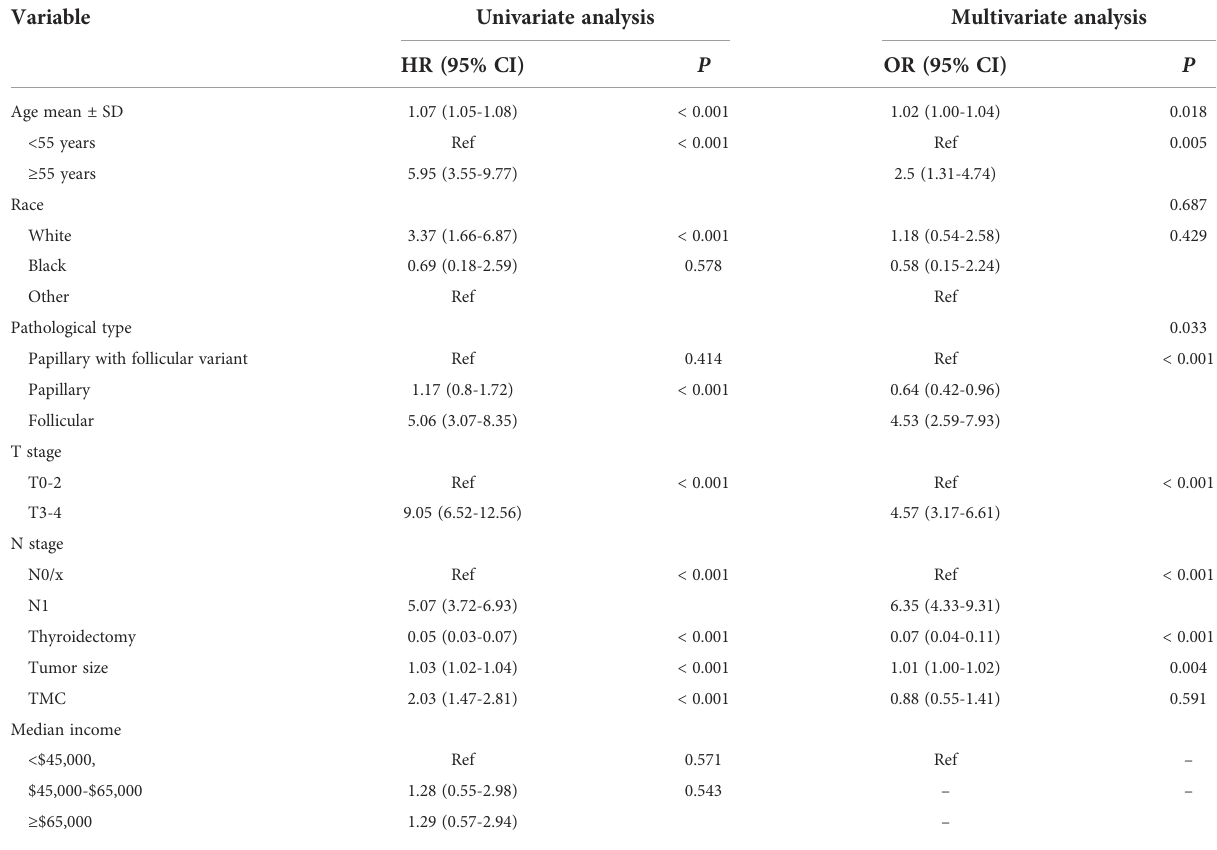
TABLE 3 Univariate and multivariate logistics regression analyses of the risk factors of lung metastasis in FDTC patients.